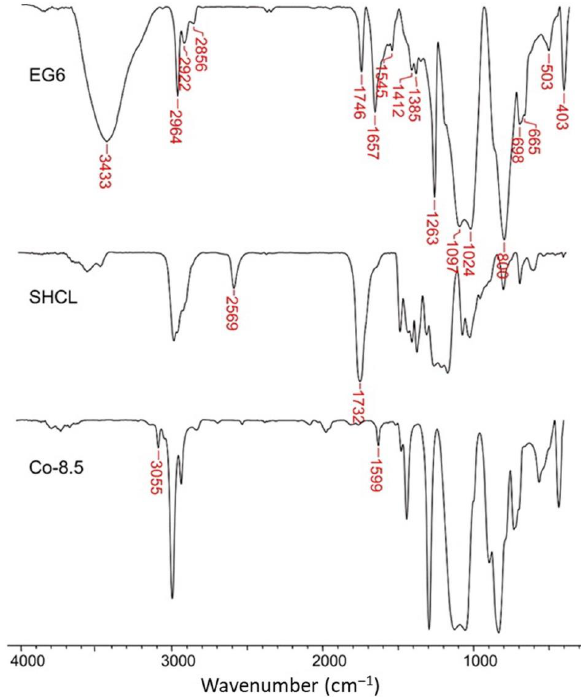
Figure 2. FT-IR spectra of Co-8.5, SHCL, and the reaction product (EG6). Gels 2022 , 8 , x FOR PEER REVIEW When the dilute toluene solution of T was used as a continuous phase, having a vinyl- containing siloxane copolymer dissolved, together with an SH-containing cross-linker and the photoinitiator, a low amount of water was introduced as the internal phase (10 – 20%). The mixture was submitted to UV irradiation and the obtained gels (Figure S3) were dried in ambient conditions before SEM analysis. As can be observed in Figure 3, porous materials were obtained, presenting a “double emulsion structure” [2] with b oth large (micron size) pores distributed on a “sea island” pattern and small (submicron) ones, as well as combinations of these (Figure 3c). A similar composition, wherein PEG was dis- solved in the water phase, gave a polymer – polymer composite. Its SEM images (Figure 3d,e) clearly show micron size PEG particles (instead of the large pores in the previous example) and small pores (Figure 3d). The observed morphology of this composite mate- rial confirms the fact that the initial emulsion served as a template, since PEG particles are indeed formed in the w/o domains.